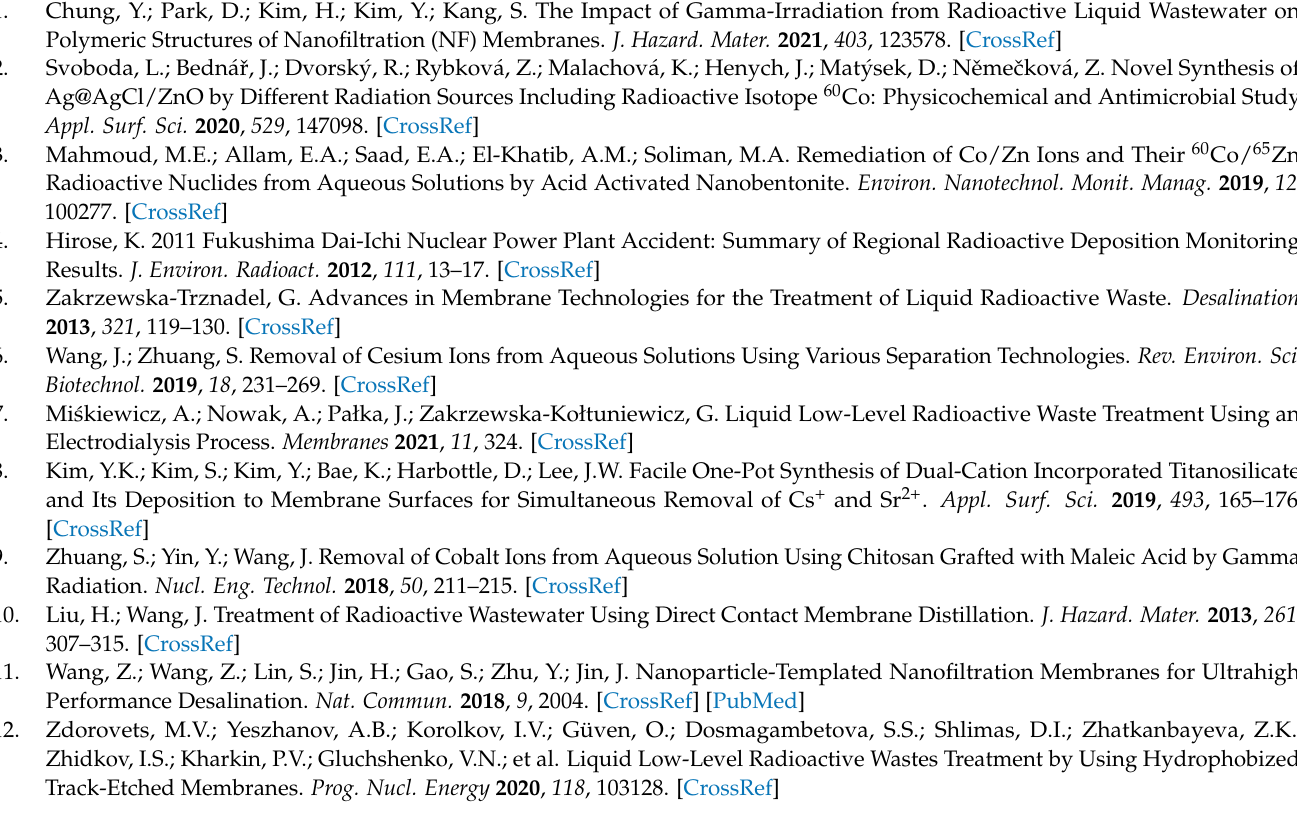
Figure S3: Water permeances and rejection rates of the GO and AH-rGO membranes for 50 mg/L CoCl 2 solutions. All tests were repeated on three different samples, and the error was calculated from these three measurements. Figure S4: Filtration performance of AH-rGO membranes prepared with 70 ◦ C, 80 ◦ C, and 90 ◦ C. Figure S5: Stability of AH-rGO and pure GO membrane in the aqueous solu- tion treated with 40 kHz ultrasound for 120 min. Figure S6: Antifouling performance measurements of the AH-rGO membrane. The permeance and rejection rate of AH-rGO membrane for the 50 mg/L CoCl 2 solution after surface and filtration cleaning with DI water. Table S1: Comparisons of different nanofiltration membranes in water permeance and rejection rates for the ions (Co 2+ , Zn 2+ , Ni 2+ , and the typical divalent ion) in the literature. References [43–52] have been cited in Supplementary